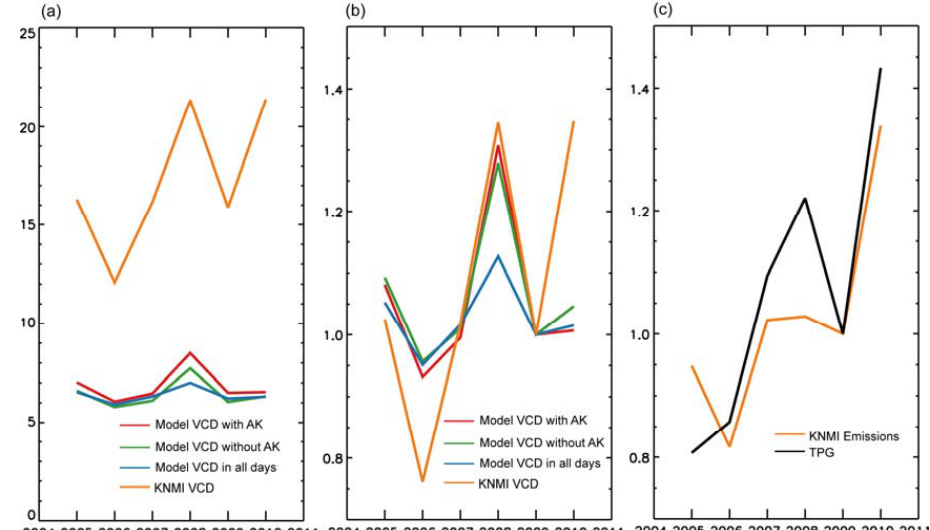
Fig. 9. Similar to Fig. 4 but for